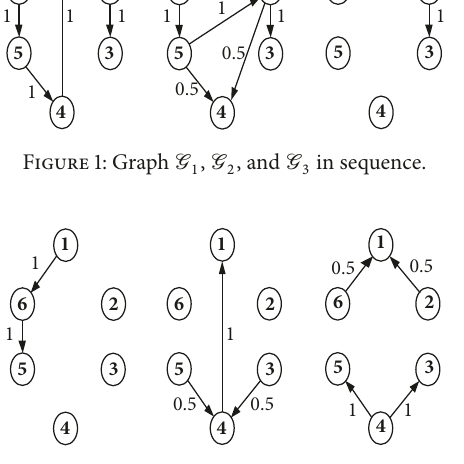
Figure 2: Graph G 4 , G 5 , and G 6 in sequence.